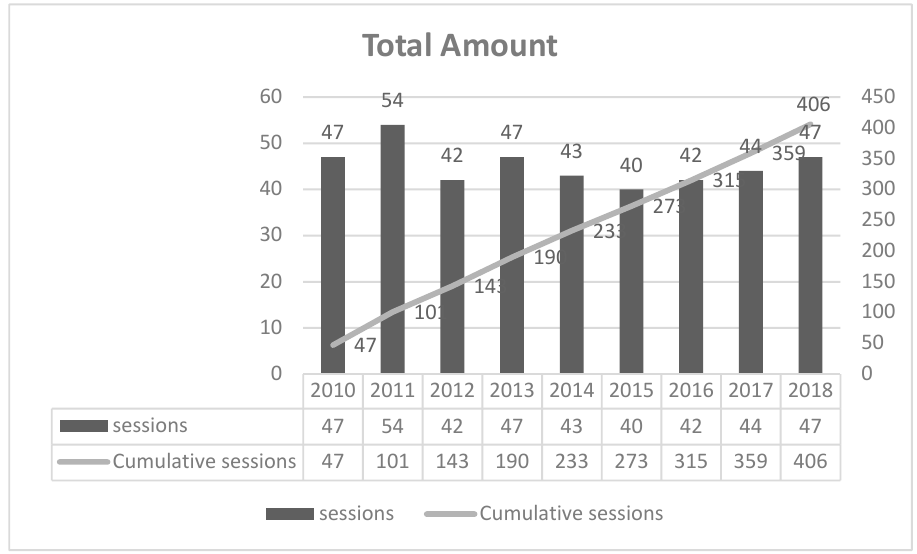
Figure 13. Cumulative sessions table of the number of activities of Kaohsiung Dome in 2000–2018. J. Open Innov. Technol. Mark. Complex. 2019 , 5 , x FOR PEER REVIEW